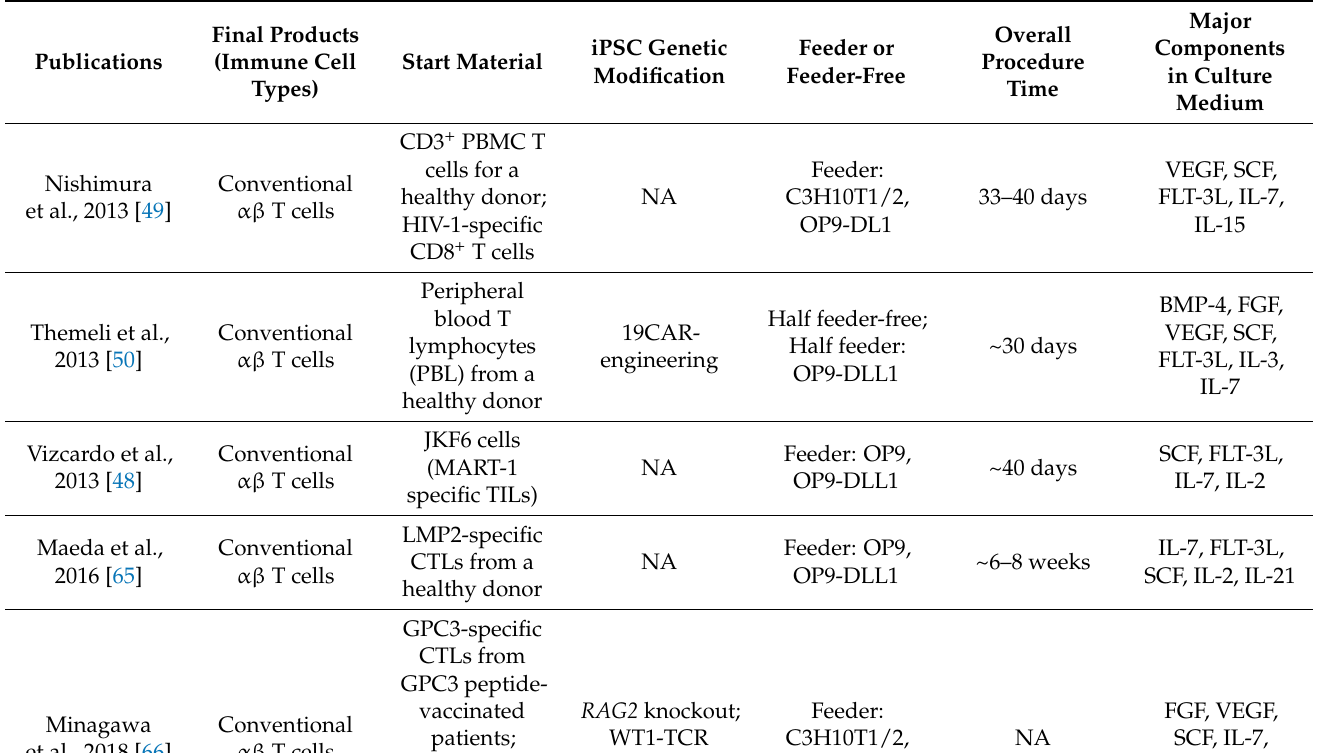
Table 3. Representative in vitro differentiation methods of generating iPSC-derived T cells for cancer cell